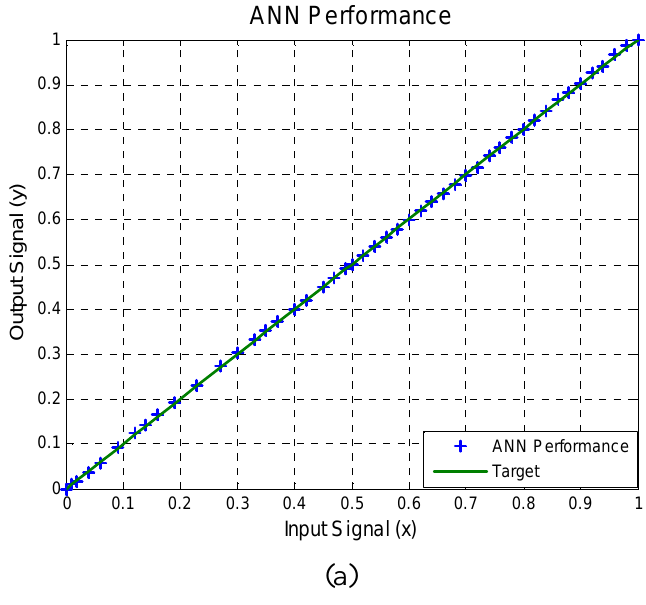
Figure 6. ANN performance with five calibration points. a) Output ANN signal. b) ANN output relative